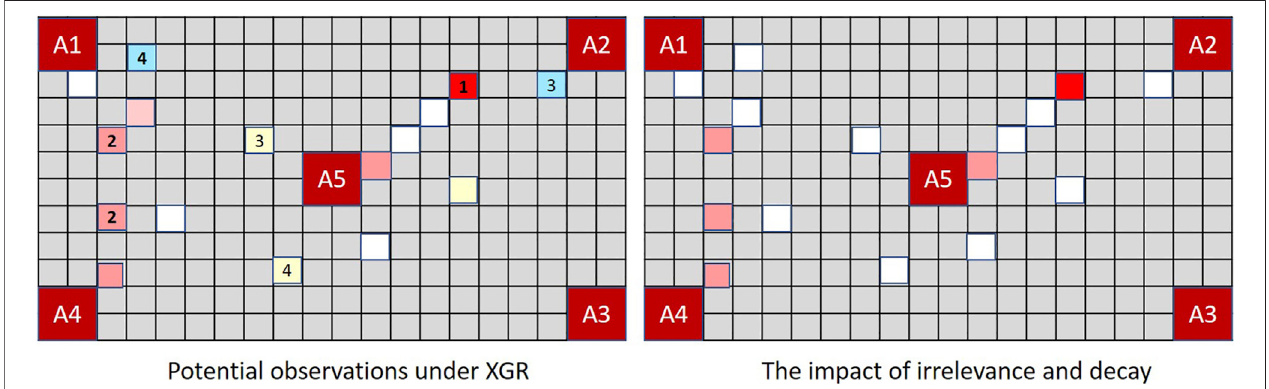
FIGURE 8 | The board on the left shows observations potentially recalled under XGR following the second turn (true state as depicted in Figure 7 ). When dimly rememberedobservations and thoseperceivedtobeirrelevantdeterminetherateofdecay,thestoredstateofahumanorextended GRsystemresemblesthe fi gureon the right. Adopting a worst case assumption such that misremembered and unobserved tokens are incorporated into Player B ’ s assessment as potential reds, a GR system extended to forget ranks ( A 2, A 5) as more likely than other possible goals (cost difference (cid:1) − 5). A traditional GR system, which — since every action has beenfullyobservable — hasbeenabletotrackthecompletestate,nowranks(A1,A4)asmostprobablewithacostdifferenceof − 3,asagainstthe actual costdifference for ( A 2, A 5) of 7 − 8 (cid:1) −